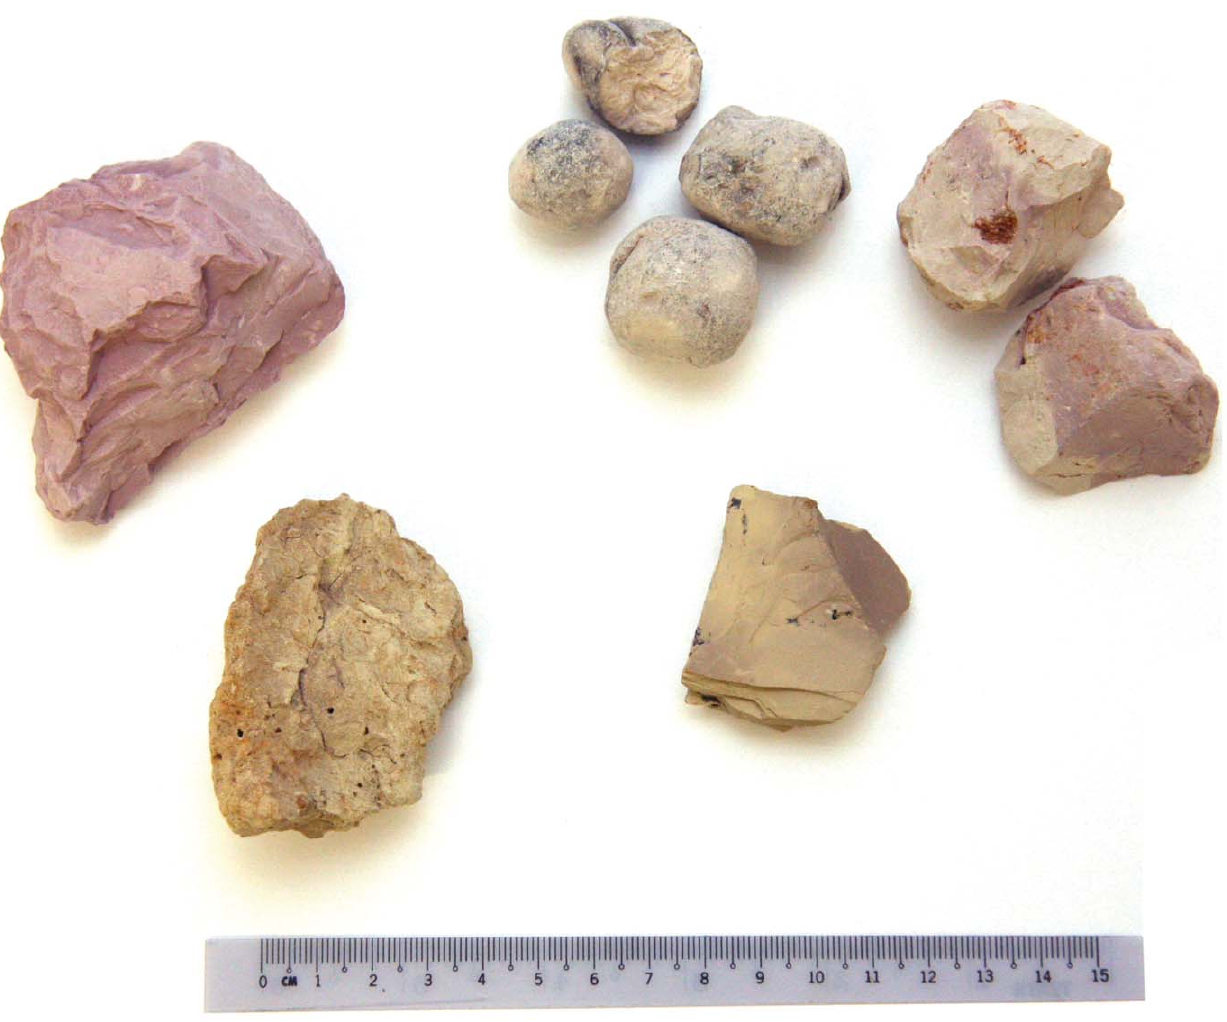
Figure 2. Five of the Calabash chalk samples investigated in our study. These materials are shales (top left [sample 8 as listed in Table 3] and bottom right [sample 4]) and dried/baked soils (samples 9, 6 and 5, top middle and right, and bottom left, respectively). Photograph: Peter W. Abrahams.